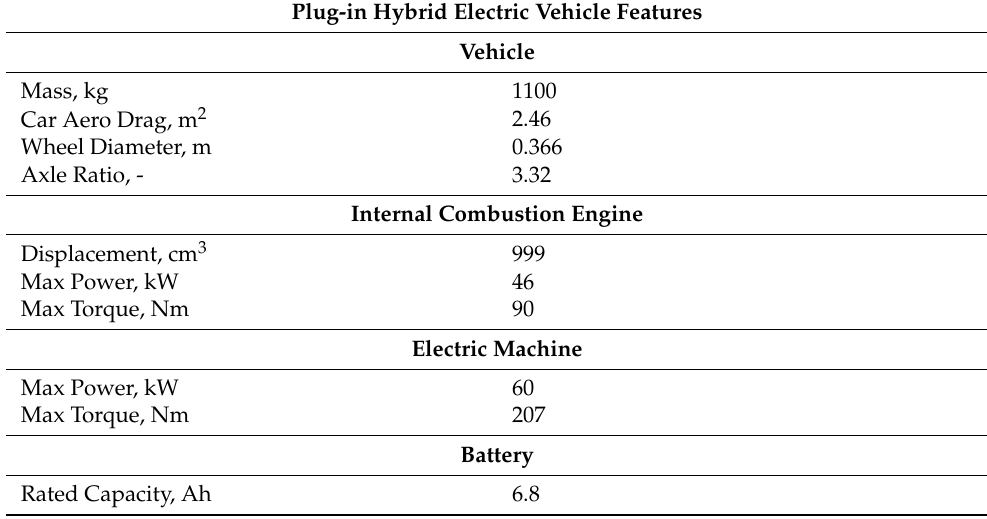
Figure 1. Powertrain schematic of tested PHEV. Table 1. Main characteristics of the tested PHEV.